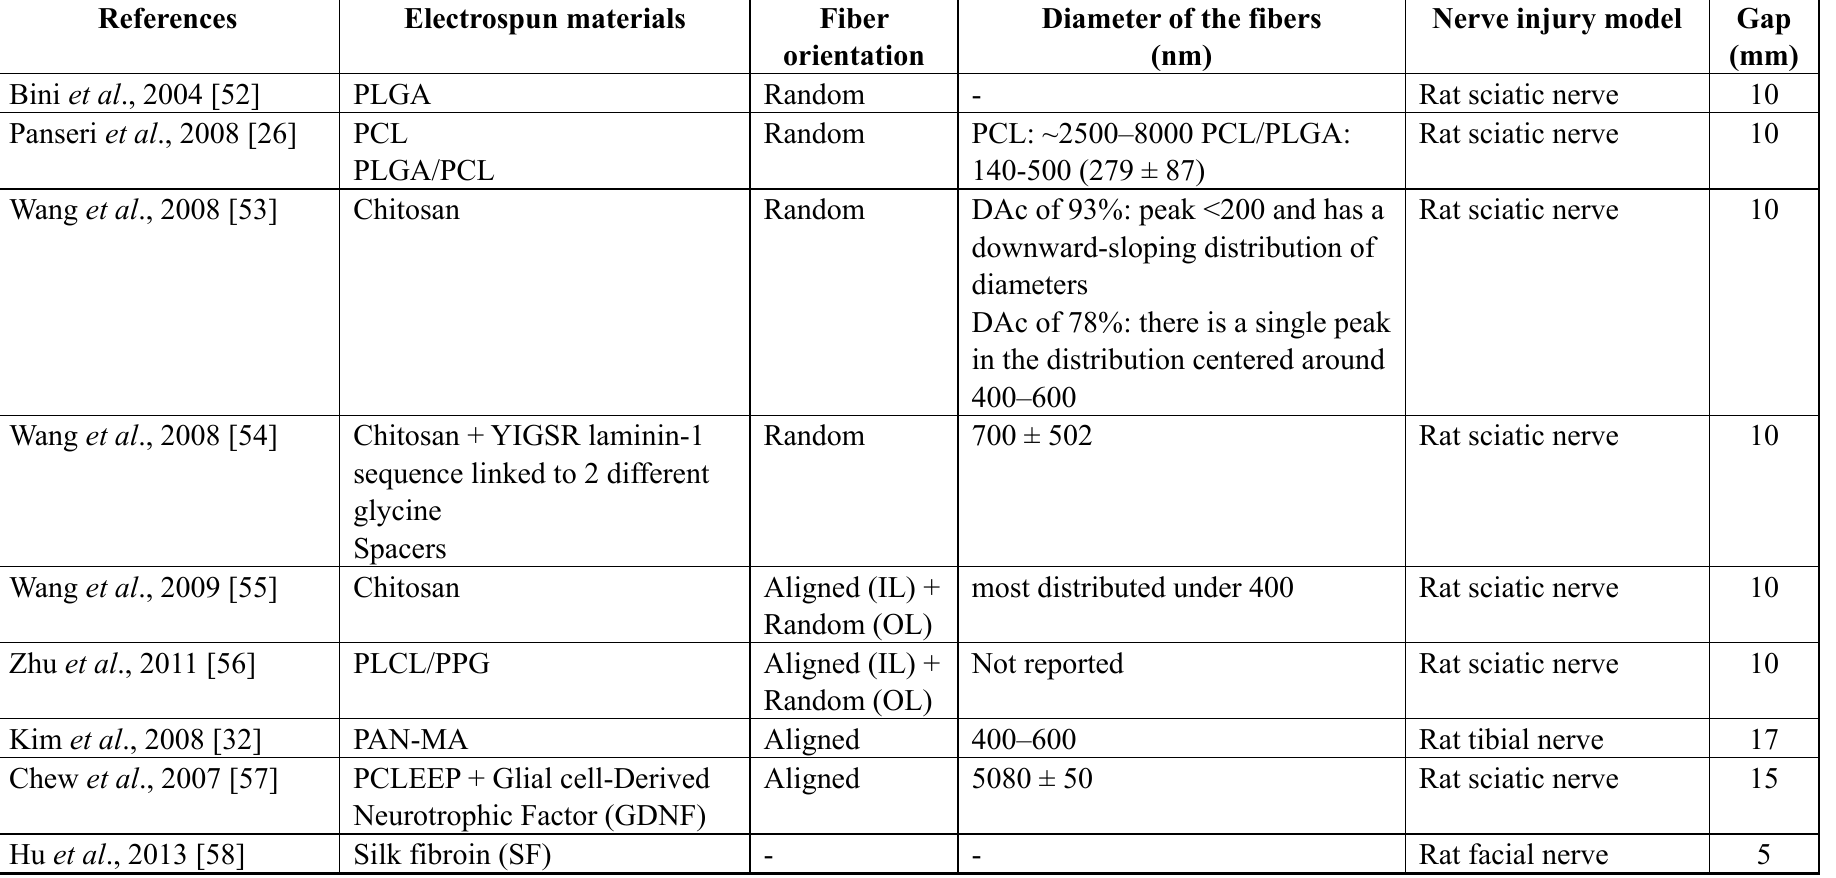
Table 3. Main features of the electrospun materials used in in vivo studies. Legend: IL: inner layer; OL: outer